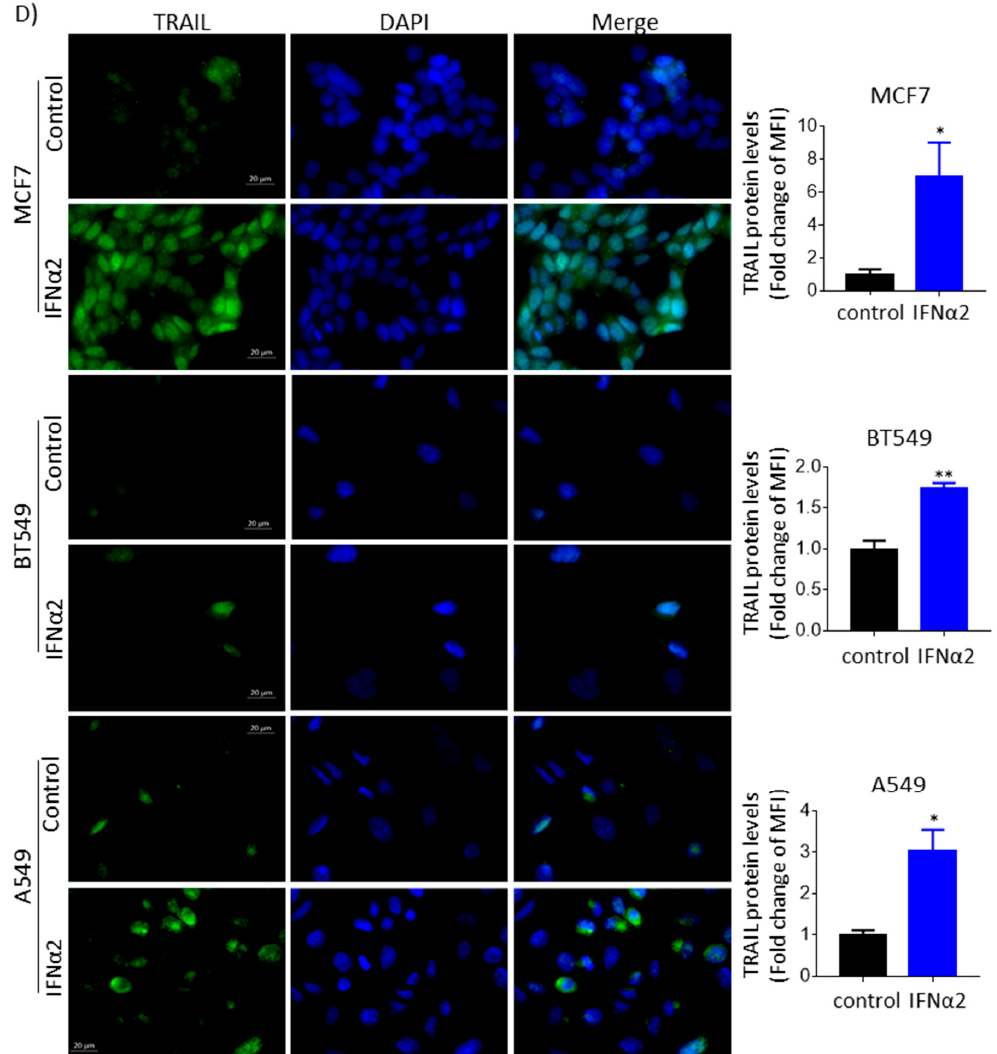
Figure 1. TRAIL RNA and protein levels are upregulated by IFN α in cancer cells. ( A ) TRAIL RNA expression increased upon IFN α and IFN γ treatment but not upon TNF α or IL-6 treatment in THP-1. Cells were treated with 1 µ g/mL TNF α , 0.8 µ g/mL IFN α 2, 1 µ g/mL IFN γ or 100 ng/mL IL-6 for 6 or 24 h, and TRAIL levels were quantified using qPCR. ANOVA followed by Dunnett’s multiple comparison test was performed (** p < 0.01 and **** p < 0.0001). ( B ) TRAIL protein levels on the cell surface increased upon IFN α treatment in THP-1. Cells were treated with 0.8 µ g/mL IFN α 2 for 24 h, and membrane TRAIL protein was quantified in fresh cells using flow cytometry. Two-tailed t -test was performed (* p < 0.05). ( C ) TRAIL RNA expression increased upon IFN α treatment but not upon TNF α treatment in cancer cell lines. Breast cancer cell lines (MCF7 and BT549) and lung cancer cells (A549) were treated with 1 µ g/mL TNF α or 0.8 µ g/mL IFN α 2 for 6 or 24 h, and TRAIL levels were quantified using qPCR. ANOVA followed by Dunnett’s multiple comparison test was performed (** p < 0.01 and *** p < 0.001). ( D ) TRAIL protein levels increased upon IFN α treatment in cancer cell lines. Cells were treated with 0.8 µ g/mL IFN α 2 for 24 h (A549) or 48 h (MCF7 and BT549), and total TRAIL protein was quantified using immunofluorescence. TRAIL signal is shown in green. Nuclei were stained with DAPI (blue). Representative images are shown. Two-tailed t -test was performed (* p < 0.05 and ** p < 0.01). MFI: mean fluorescence